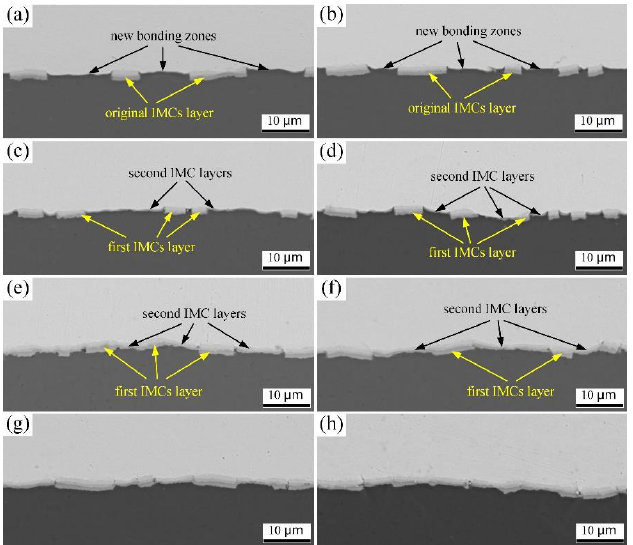
Figure 7. Interface SEM images with different annealing times: ( a , b ) 10 min, ( c , d ) 20 min, ( e , f ) 40 min, ( g , h ) 60 min; ( a , c , e , g ) peak, ( b , d , f , h ) trough.